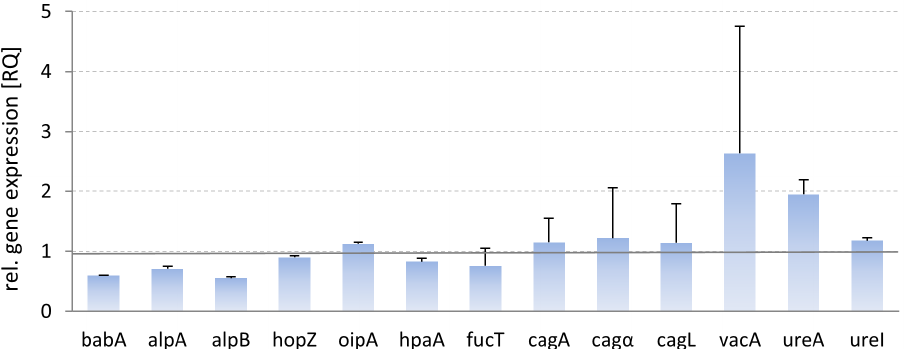
Figure 7. Differential gene expression of H.pylori pretreated with Okra FE. Endogenous control: 23S rRNA. Data are related to untreated control (UC) H. pylori in liquid growth medium (RQ=1), with n=2 replicates from three independent experiments (mean 6 SD). * p # 0.05